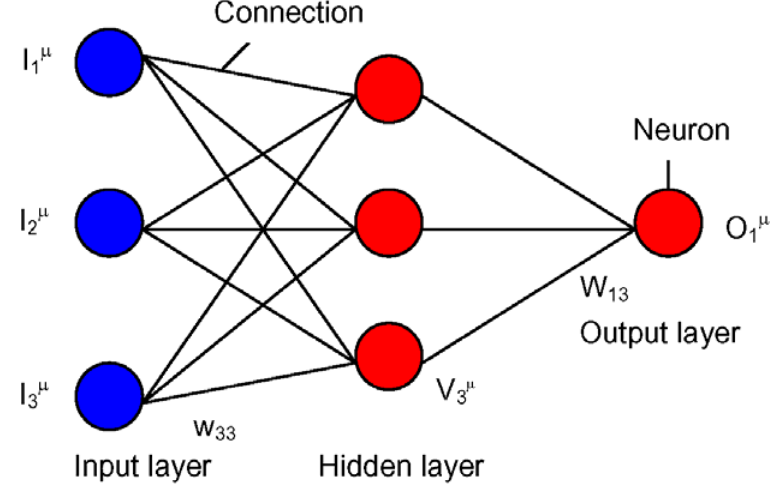
Figure 2. Feedforward neural network with a single hidden layer and one output neuron.